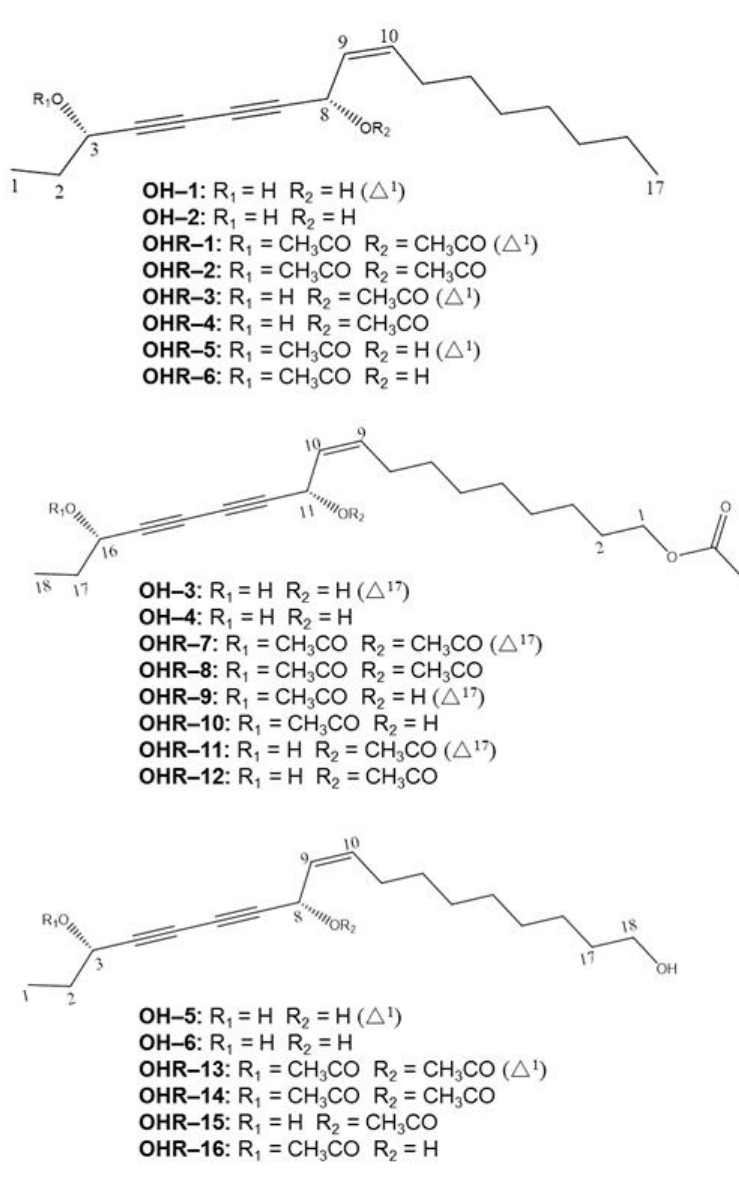
Figure 1. The structures of the isolated and derivative